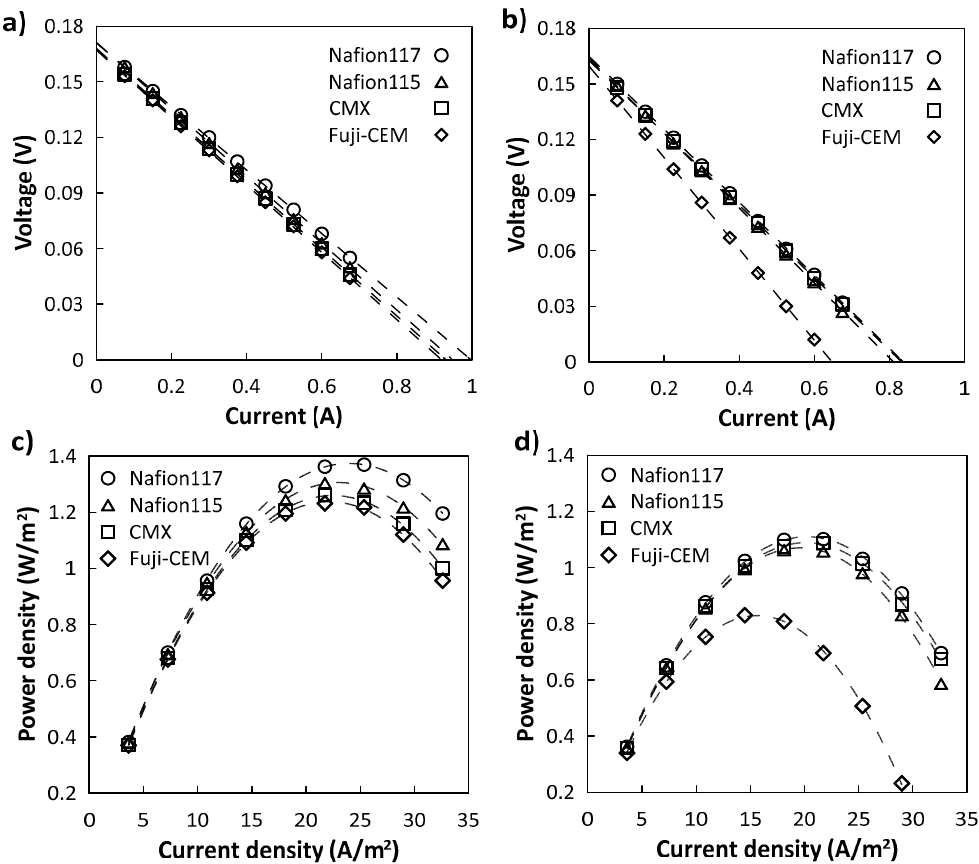
Figure 9. RED performance of the four commercial CEMs investigated: ( a , b ) voltage versus current; ( c , d ) gross power density versus current density. For ( a , c ) test in 0.5 / 4.0 M NaCl; for ( b , d ) test with 0.34 M NaCl + 0.054 M MgCl 2 / 2.7 M NaCl + 0.43 M MgCl